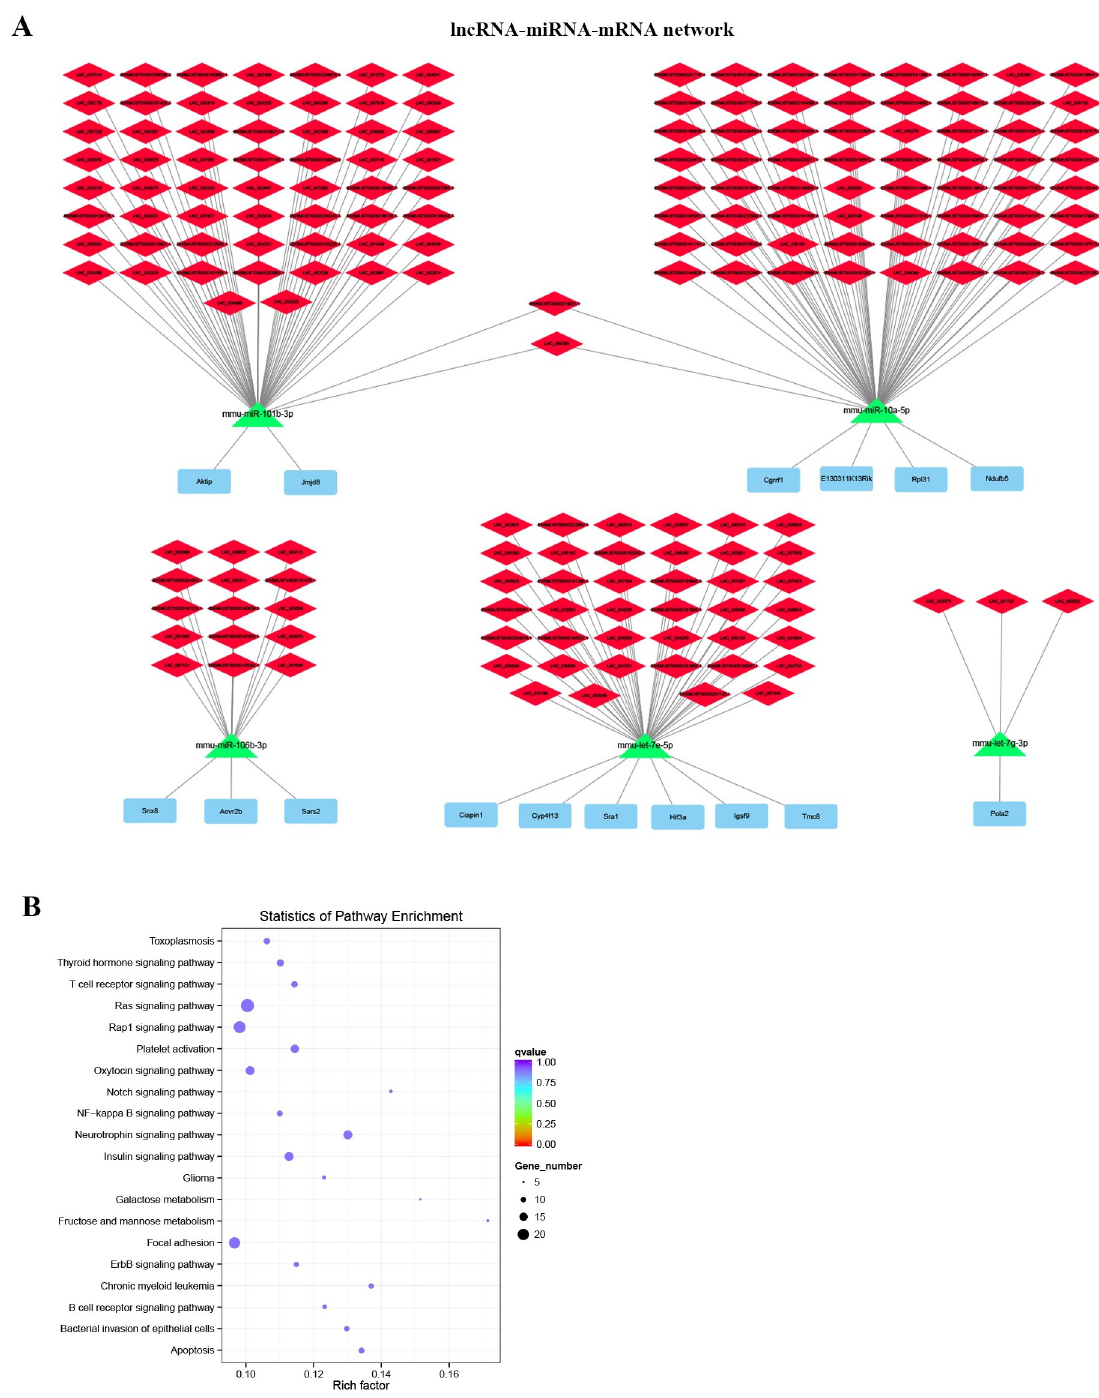
Fig 6. Construction of lncRNA-miRNA-mRNA network in ALI mouse model. (A) The lncRNA-miRNA-mRNA networks. (B) The bubble plots of KEGG pathway enrichment of DE mRNAs that involved in lncRNA-miRNA-mRNA network.